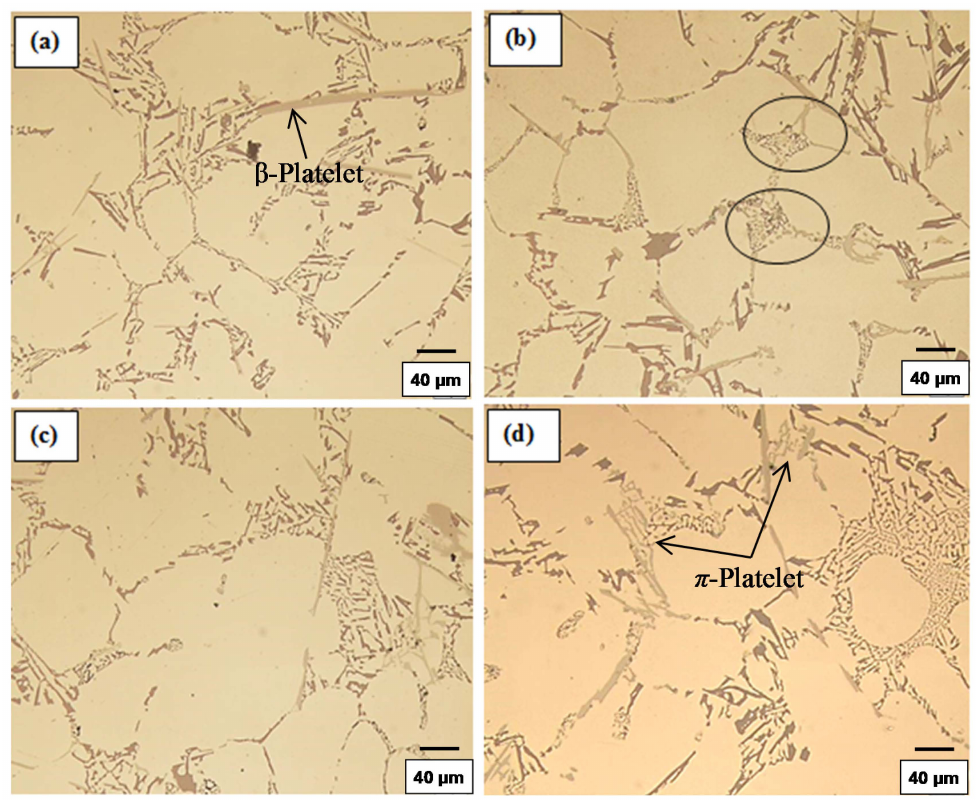
Figure 2. Silicon particle morphology and distribution in: ( a ) C3; ( b ) C3B; ( c ) C3S; and ( d ) C3BS alloys, DAS ~ 25 µ m; fine eutectic Si particles are circled in ( b ).